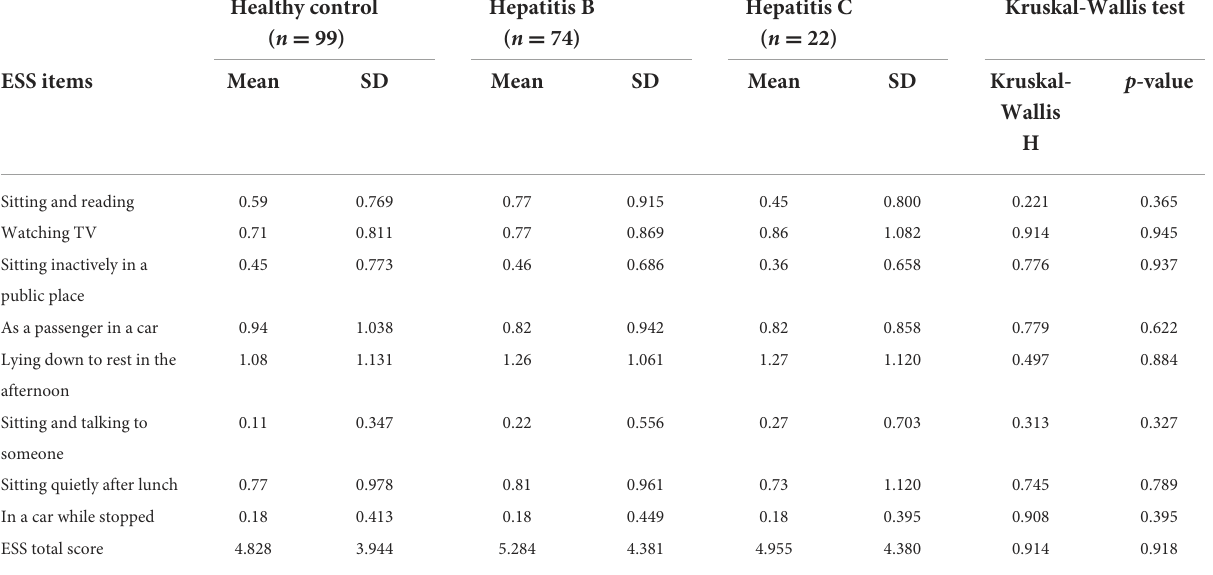
TABLE 5 The evaluation of sleep disturbance profiles with ESS between different study groups. Healthy control Hepatitis ( n = 99)